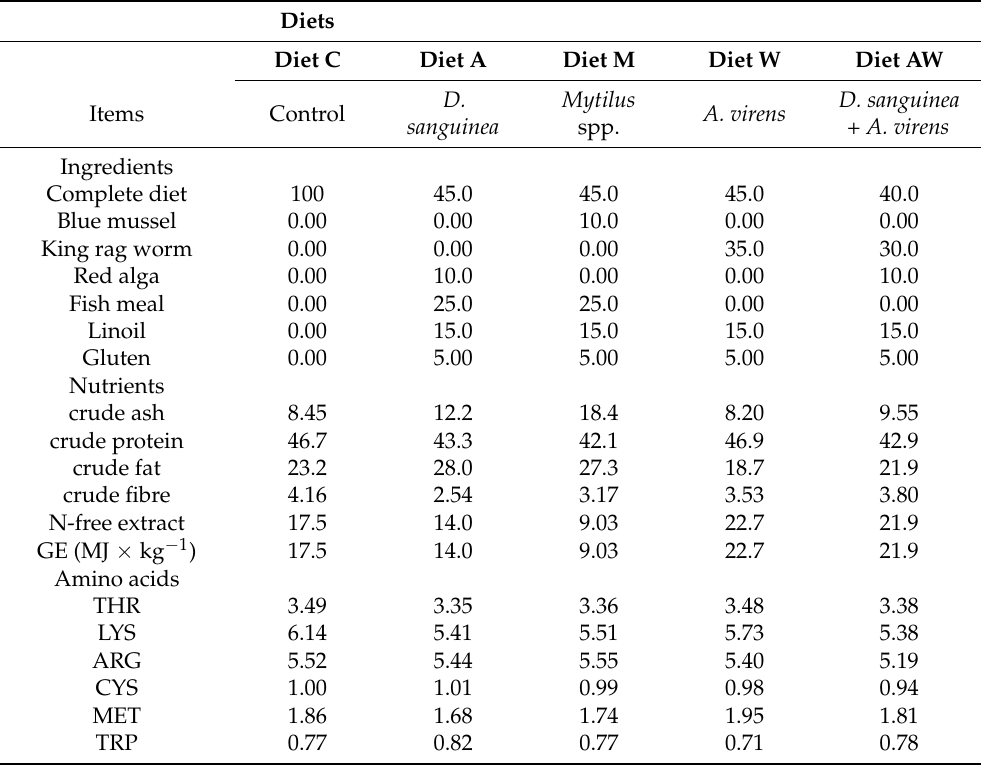
Table 2. Formulation of experimental diets, analytical nutrient composition and gross energy content (GE MJ × kg − 1